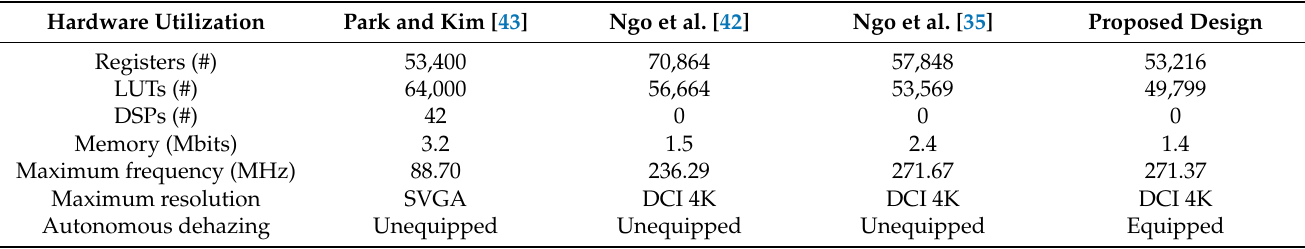
Table 5. Comparison with existing benchmark designs. The symbol # denotes